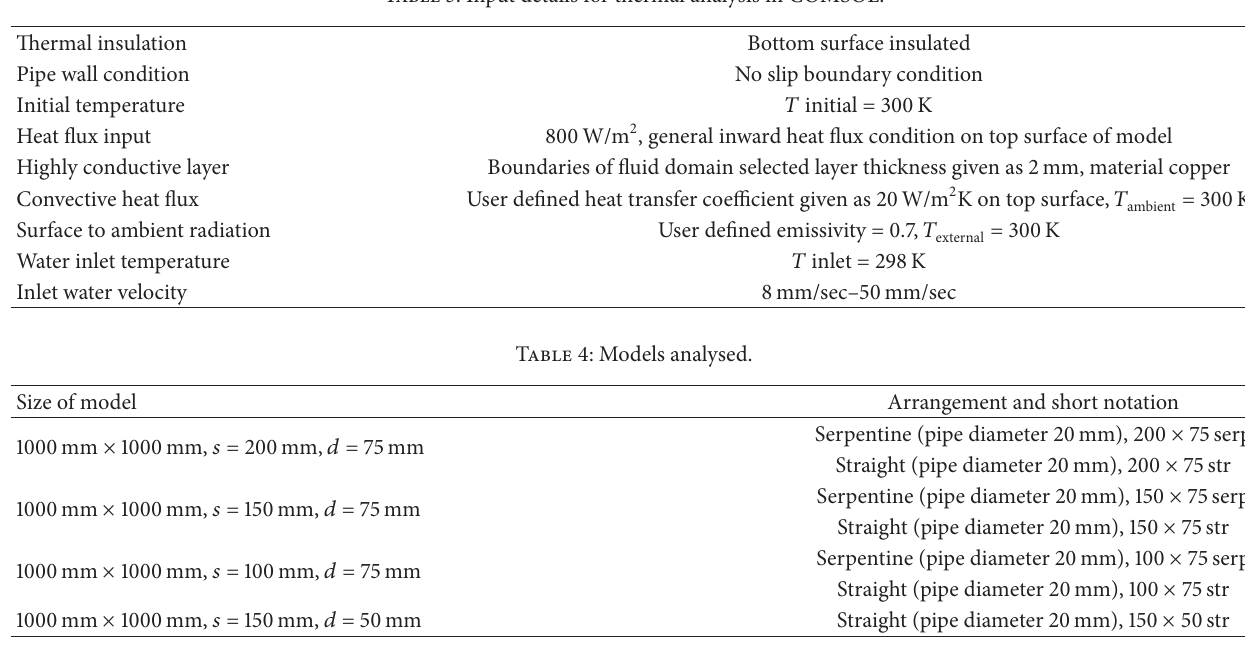
Table 3: Input details for thermal analysis in COMSOL.